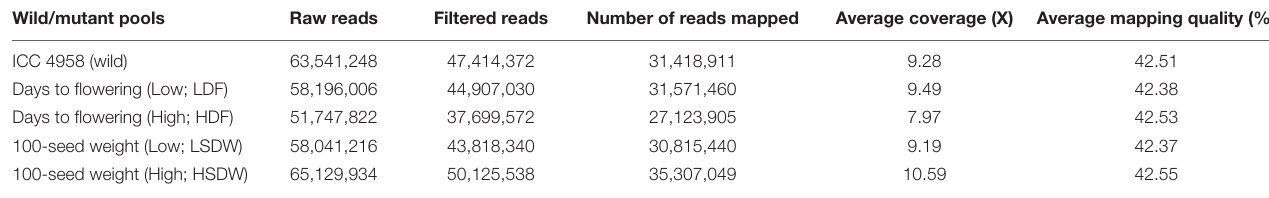
TABLE 1 | Summary of data generated and aligned on wild and mutant pools. Wild/mutant